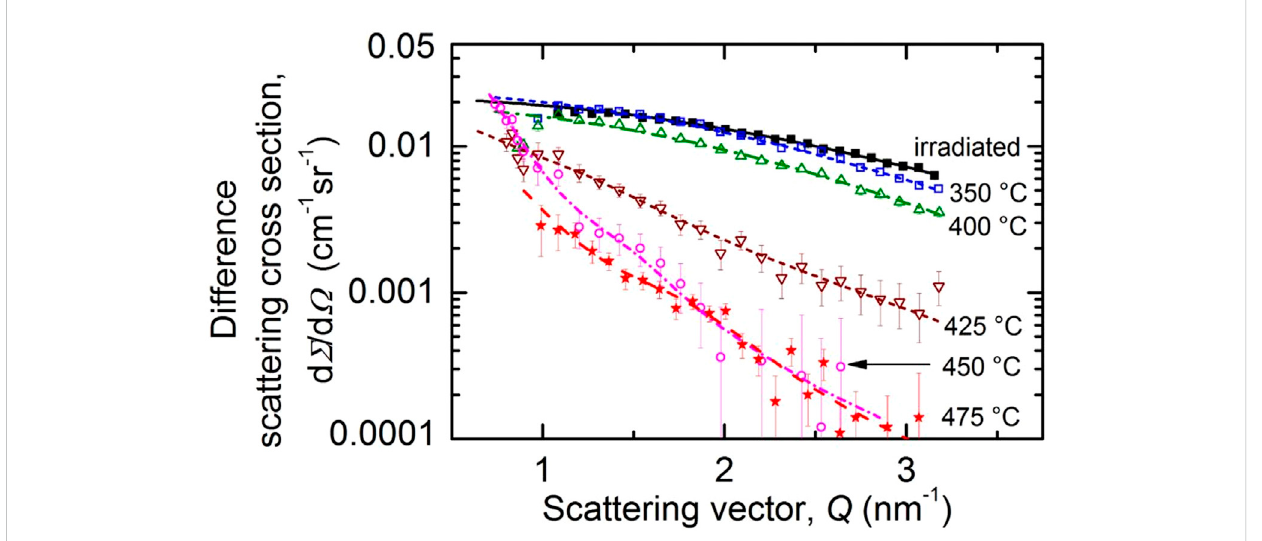
FIGURE 4 Measured magneticdifference scattering cross sections for the as-irradiated and post-irradiation annealed conditions of the weld material with the unirradiated condition subtracted. The lines are the fi tted Fourier counterparts of the size distributions.